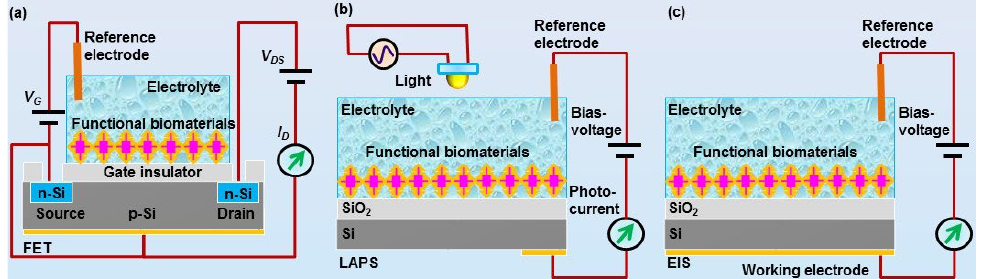
Figure 3. Schematics of field-effect devices utilkized for the development of field-effect sensors using biomaterials for chemical sensing, including ( a ) field-effect transistor (FET), ( b ) light-addressable potentiometric sensor (LAPS), and ( c ) electrolyte-insulator-semiconductor (EIS) sensor.